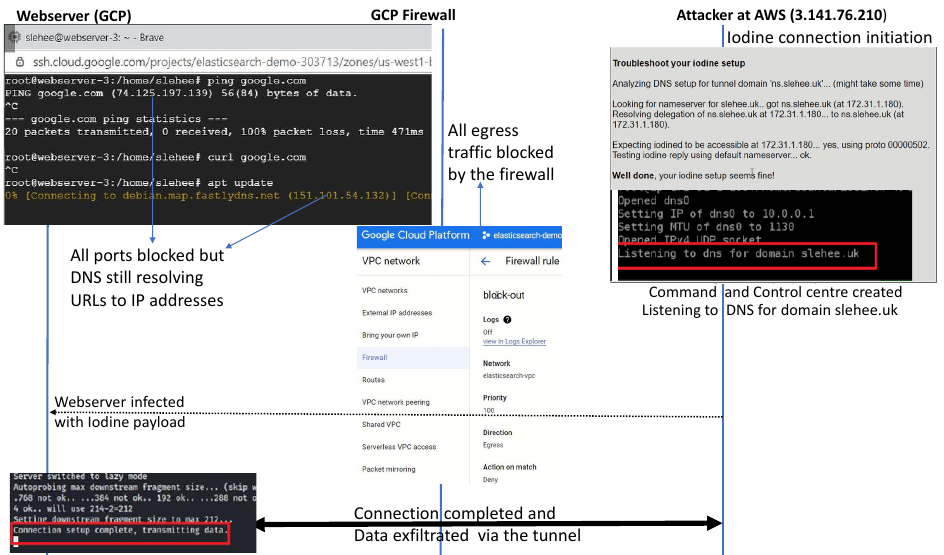
Figure 5. Experiment 2: Sequence diagram showing DNS tunnel initiation and data exfiltration under the constraints of firewall blocking all the